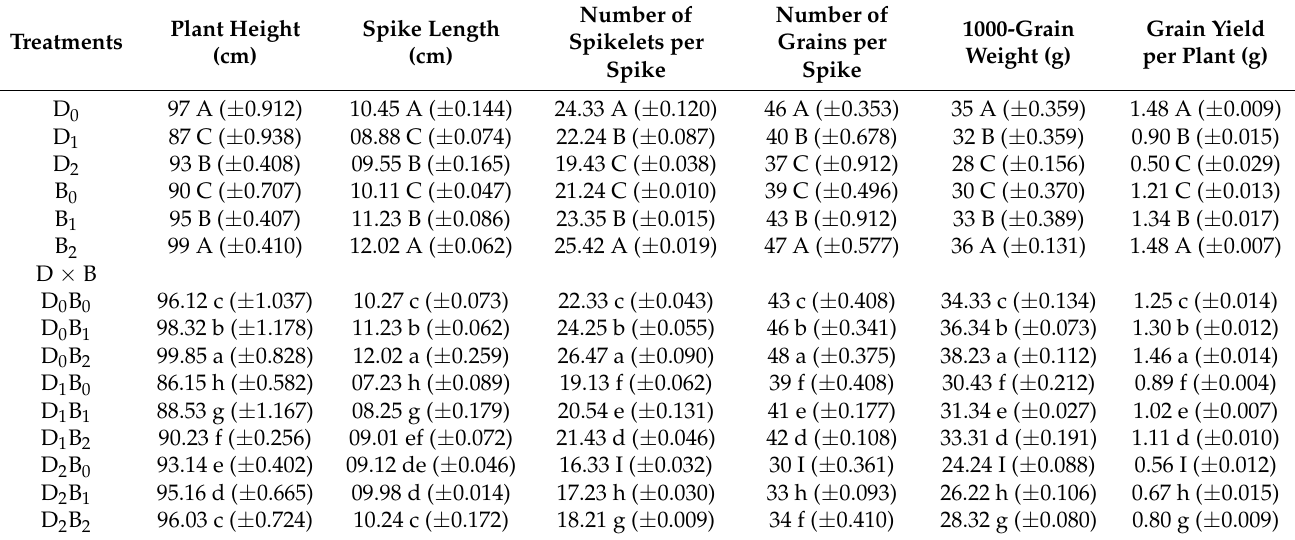
The different letter shows a significant difference in treatments at 5% probability level. D 0 = Control, D 1 = Drought at tillering stage, D 2 = Drought at grain filling, B 0 = (No-Biochar), B 1 = 28 g kg − 1 Biochar, B 2 = 38 g kg − 1 Biochar. Values in brackets are standard error of the mean ( n =